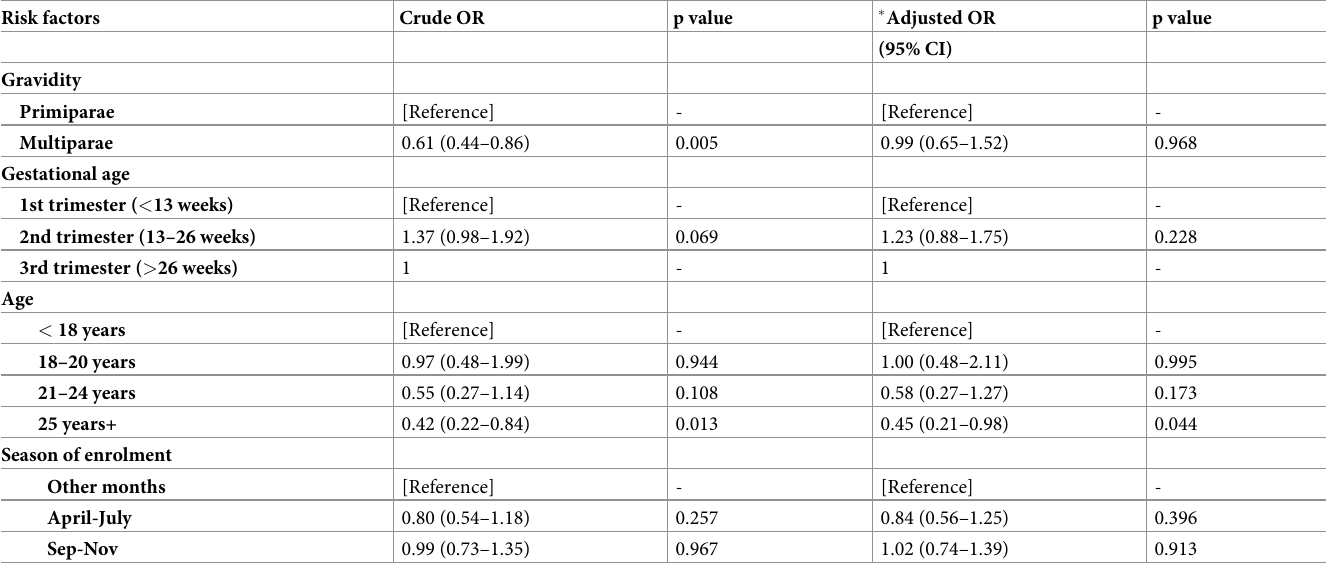
Table 4. Risk factors for P . falciparum malaria infections at enrolment.